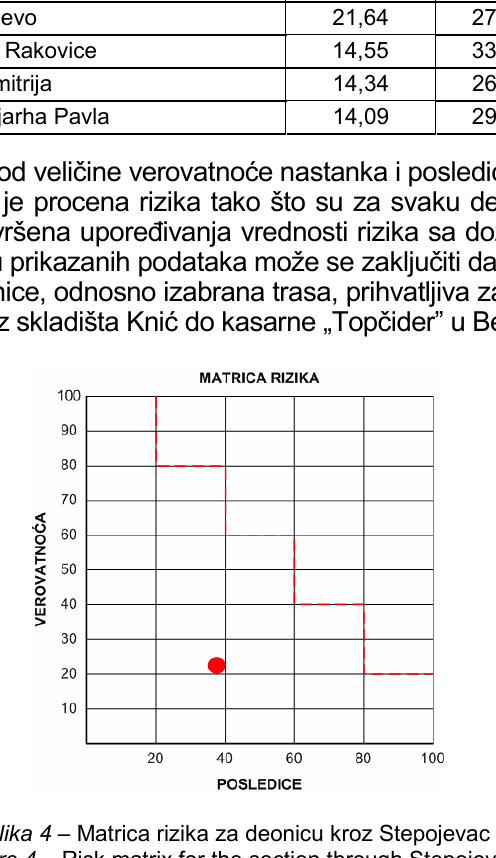
Figure 4 – Risk matrix for the section through